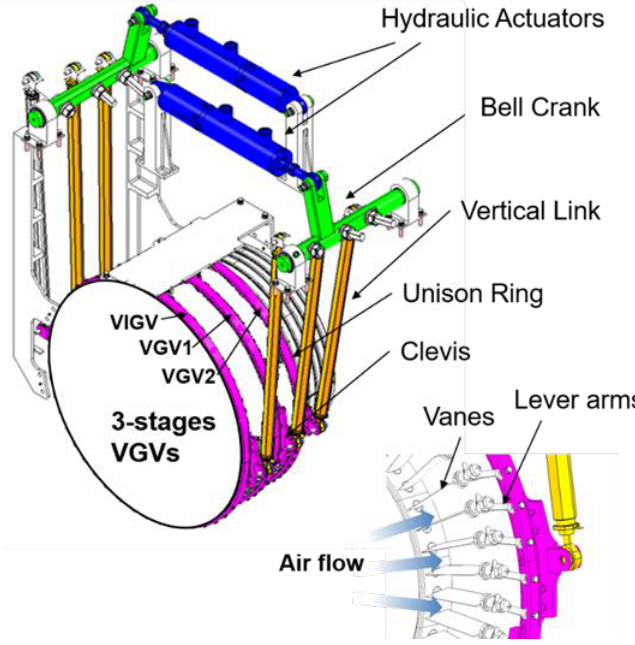
Figure 1. Variable guide vane (VGV) link mechanism of the compressor.